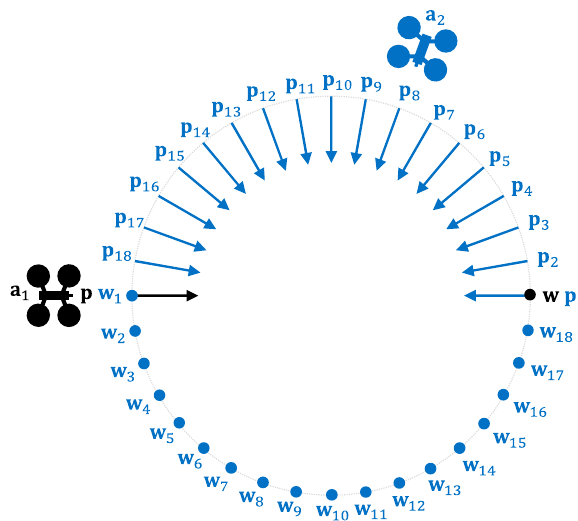
Figure 6. Two-UAV scenarios: relative angles between trajectories.